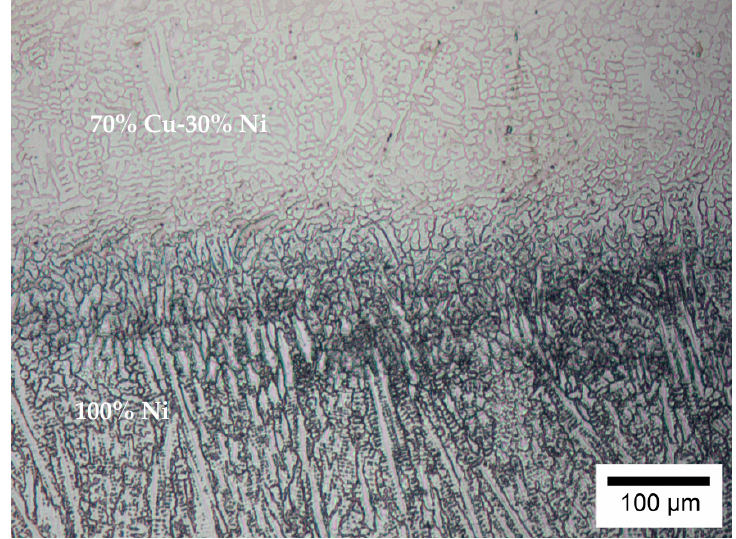
Figure 10. Optical microscope image of the dissimilar material interface on a graded material deposit fabricated by depositing 30/70 on 100/0 using the set 1 duty cycle ramp (see Figure 2). Line scan EDS analysis was performed to realize the variations in chemistry across the height of the deposit. The nickel, copper, and silicon contents were monitored to realize the trend and nature of grading. The line scan plots are shown in Figures 11 and 12. The x-axis of these plots traverses along the height from the pre-deposit on the left, to the second deposit on the right, on the axis.